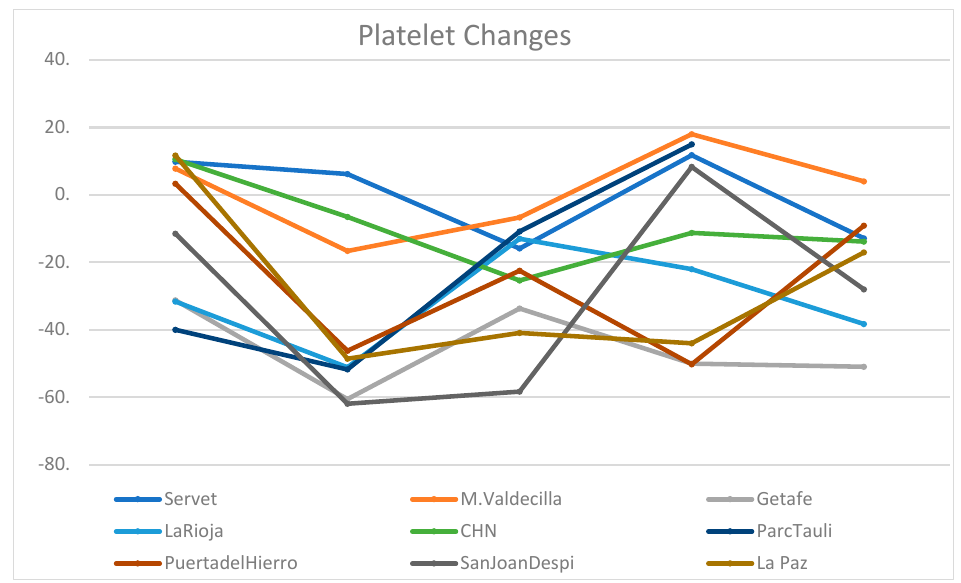
Figure A1. Change in red blood cells concentrate.